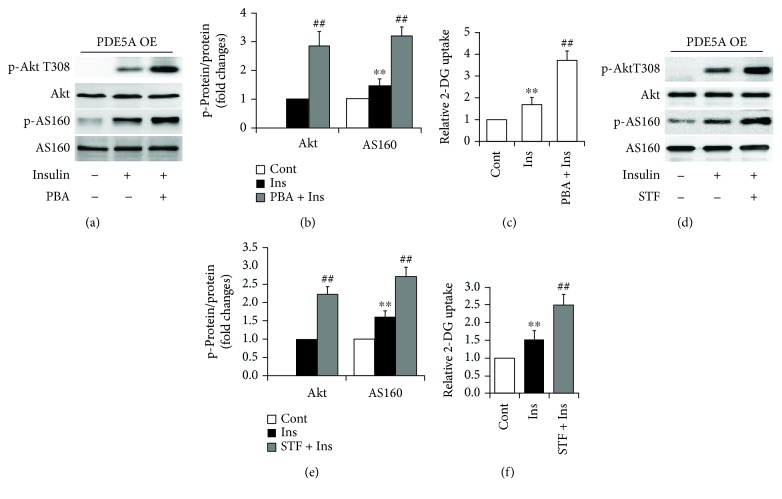
Effects of inhibition of ER stress on insulin signaling in PDE5A-overexpressed C2C12 myotubes. (a) Representative western blots showing the effects of 4-PBA on insulin- (INS-) stimulated phosphorylation of Akt T308 and AS160; (b) quantification of phosphorylated Akt T308 and AS160 in (a); (c) effects of 4-PBA on insulin-stimulated 2-DG uptake. (d) Representative western blots showing the effects of STF-083010 on insulin-stimulated phosphorylation of Akt T308 and AS160; (e) quantification of phosphorylated Akt T308 and AS160 in (d); (f) effects of STF-083010 on insulin-stimulated 2-DG uptake. N = 4. ∗∗P < 0.01 vs. the control group; ##P < 0.01 vs. the insulin-treated group.